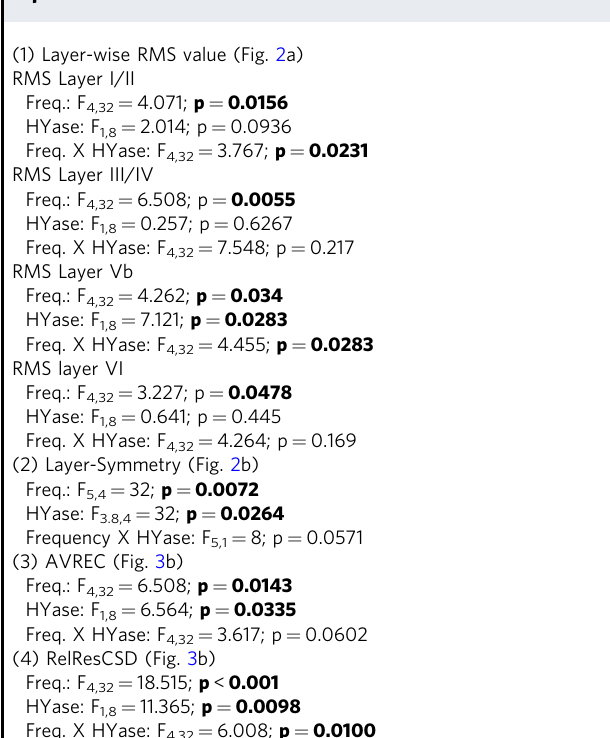
Table 1 Statistical analysis of layer-wise CSD data by repeated-measures